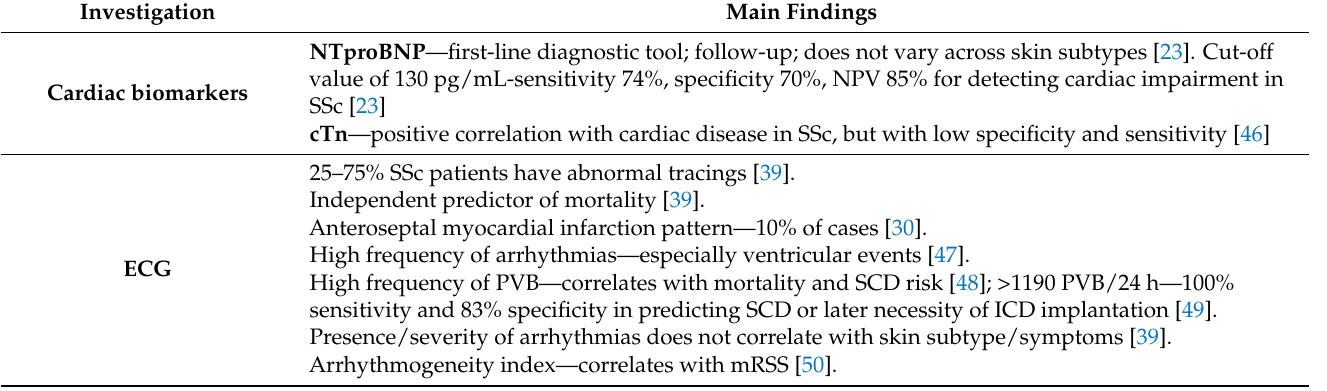
Summary of cardiac investigations used for diagnosis and follow-up in the sclerodermic